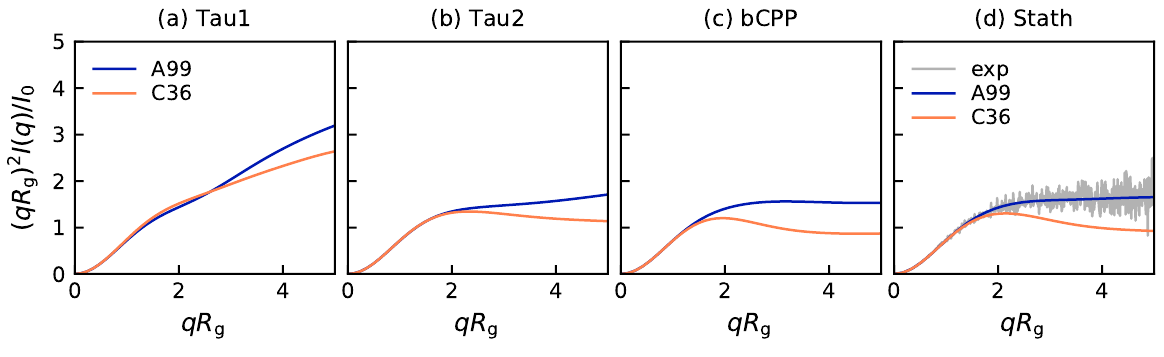
Figure 2. Dimensionless Kratky plot from simulations with Amber ff99SB-ILDN and CHARMM36m for ( a ) Tau1, ( b ) Tau2, ( c ) bCPP, and ( d ) Stath. In Panel (d), experimental data from Cragnell et al. [15] are included for comparison. The legend in Panel (a) is applicable to all